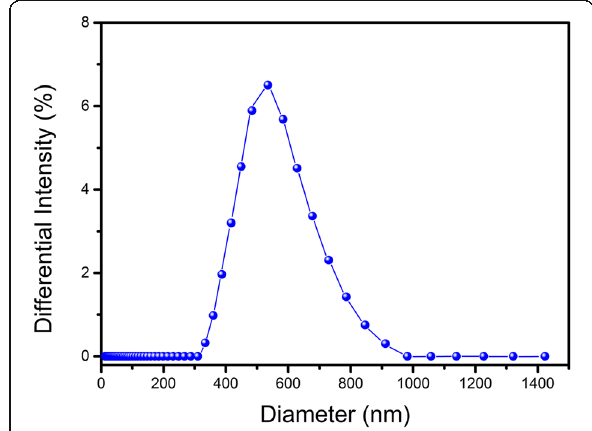
Fig. 2 The size distribution of DOX-loaded